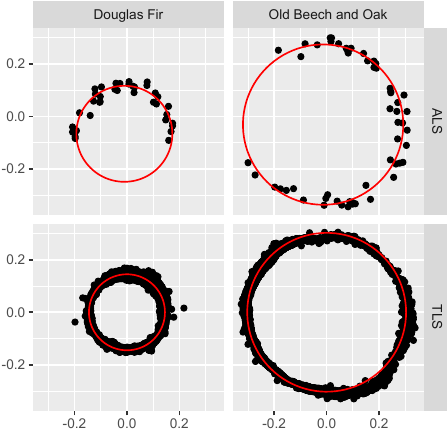
Figure 8. Samples of fitted circles to estimate DBH in the x - y -plane, x and y axis in cm.